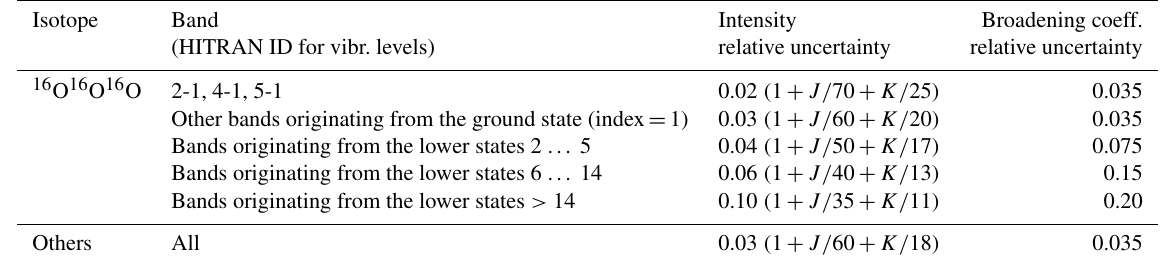
Table 2. 1 σ uncertainties of spectroscopic O 3 data as used for this work. J and K are the upper-state rotational quantum numbers. Isotope Band Intensity Broadening coeff. (HITRAN ID for vibr. levels) relative uncertainty relative uncertainty 16 O 16 O 16 O 2-1, 4-1, 5-1 0.035 Other bands originating from the ground state (index = 1) 0.03 ( 1 + J/ 60 + K/ 20 ) 0.035 Bands originating from the lower states 2 ... 5 0.04 ( 1 + J/ 50 + K/ 17 ) 0.075 Bands originating from the lower states 6 ... 14 0.06 ( 1 + J/ 40 + K/ 13 ) 0.15 Bands originating from the lower states > 14 0.10 ( 1 + J/ 35 + K/ 11 ) 0.20 Others All 0.03 ( 1 + J/ 60 + K/ 18 )